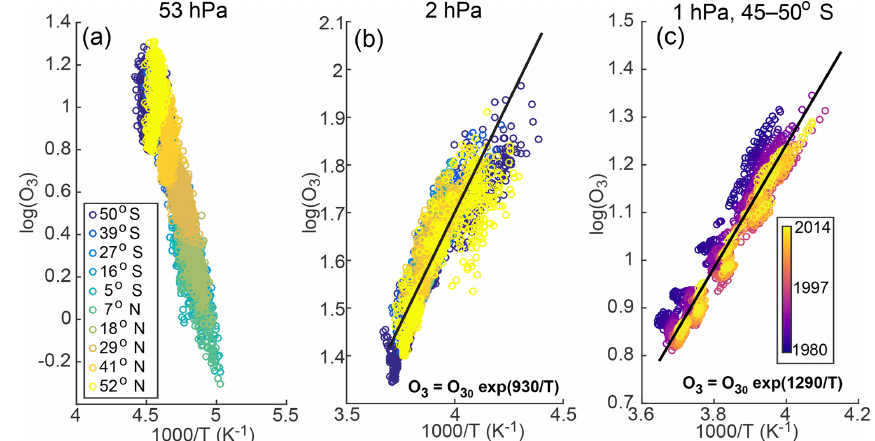
Figure 12. The natural log of the ozone volume mixing ratio (in ppm) and the colocated values of 1000 /T for different levels and latitudes in the WACCM model for 1980–2014. (a) 53hPa and (b) 2hPa; both are for all latitudes equatorward of 52 ◦ . (c) 1hPa for 45–50 ◦ S only. In (a) and (b) , different colored circles are different latitudes, with the Northern Hemisphere being yellow and the Southern Hemisphere blue. In (c) , different colors show different years. In (b) and (c) the best-fit lines are also plotted in black with correlation coefficients of r = 0 . 87 and r = 0 . 96,